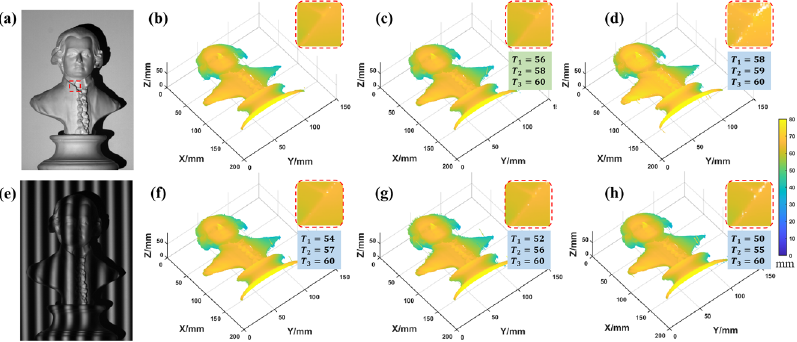
Figure 16. The ED maps between the three methods and the ground truth (the first and the second rows refer to the measured gourd and statue, respectively). ( a , d ) The ED map of the proposed method. ( b , e ) The ED map of the traditional TFH method. ( c , f ) The ED map of the DFH method (the RMSE of each method is marked).